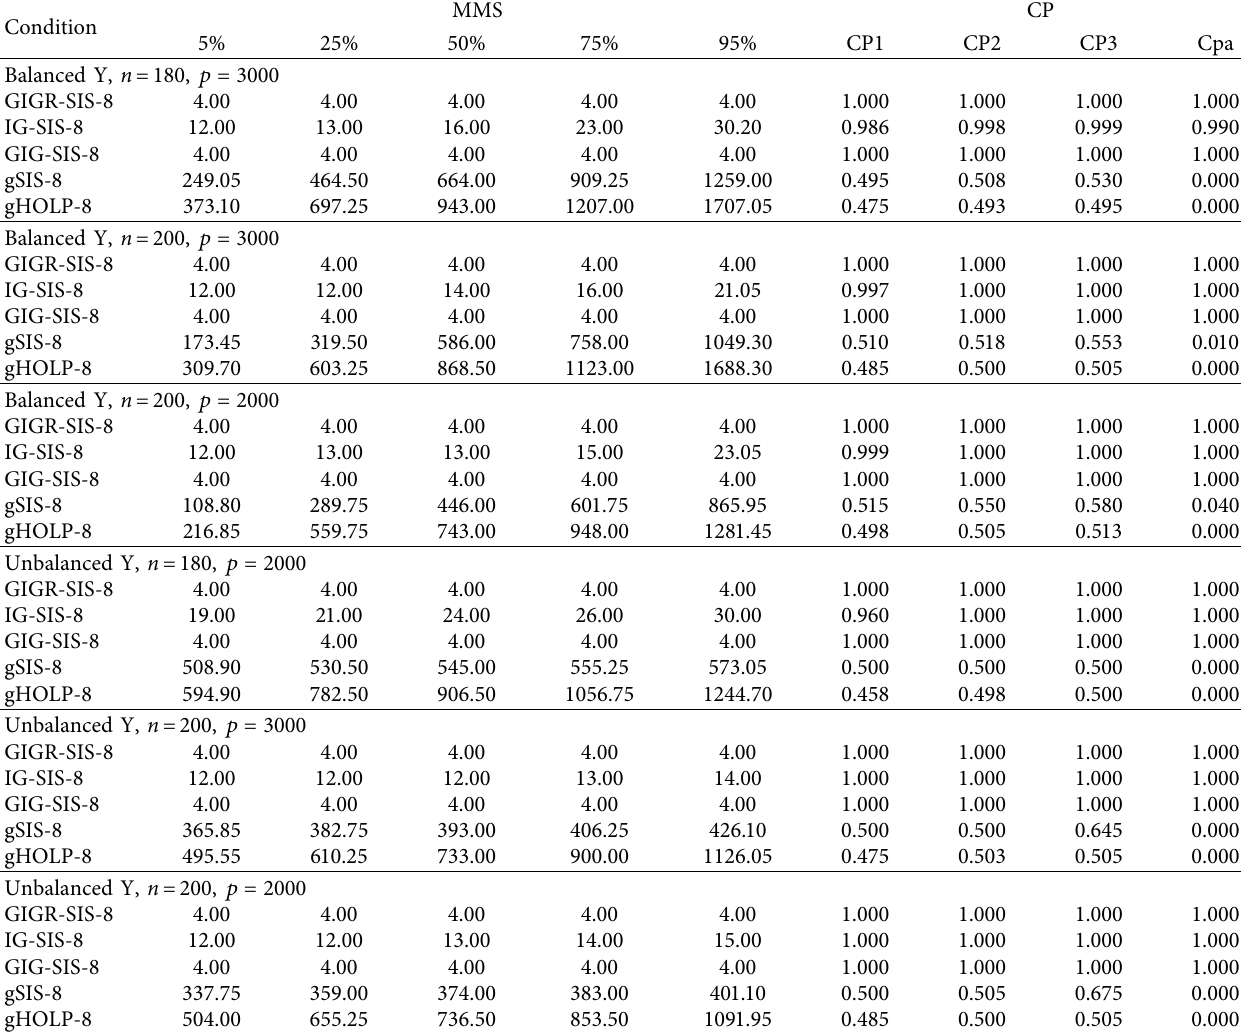
Table 6: Simulation results for Model 4.